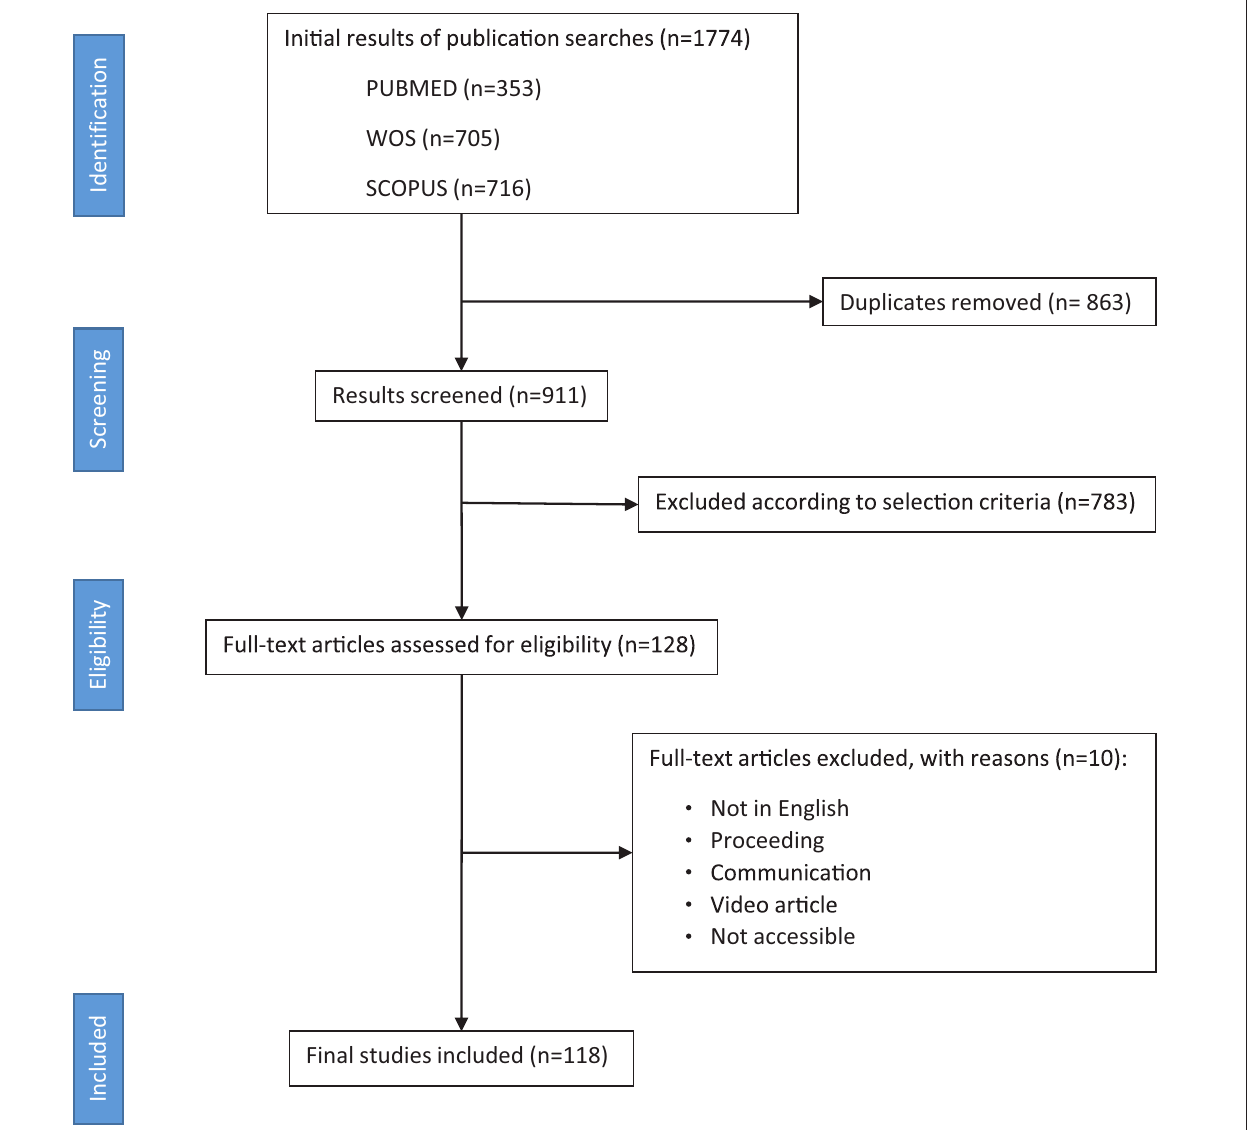
FIGURE 2 | PRISMA flow diagram depicting literature search, exclusion process, eligibility criteria, and final included papers. One hundred and eighteen papers were included without publication date restriction (search performed on April 15th,